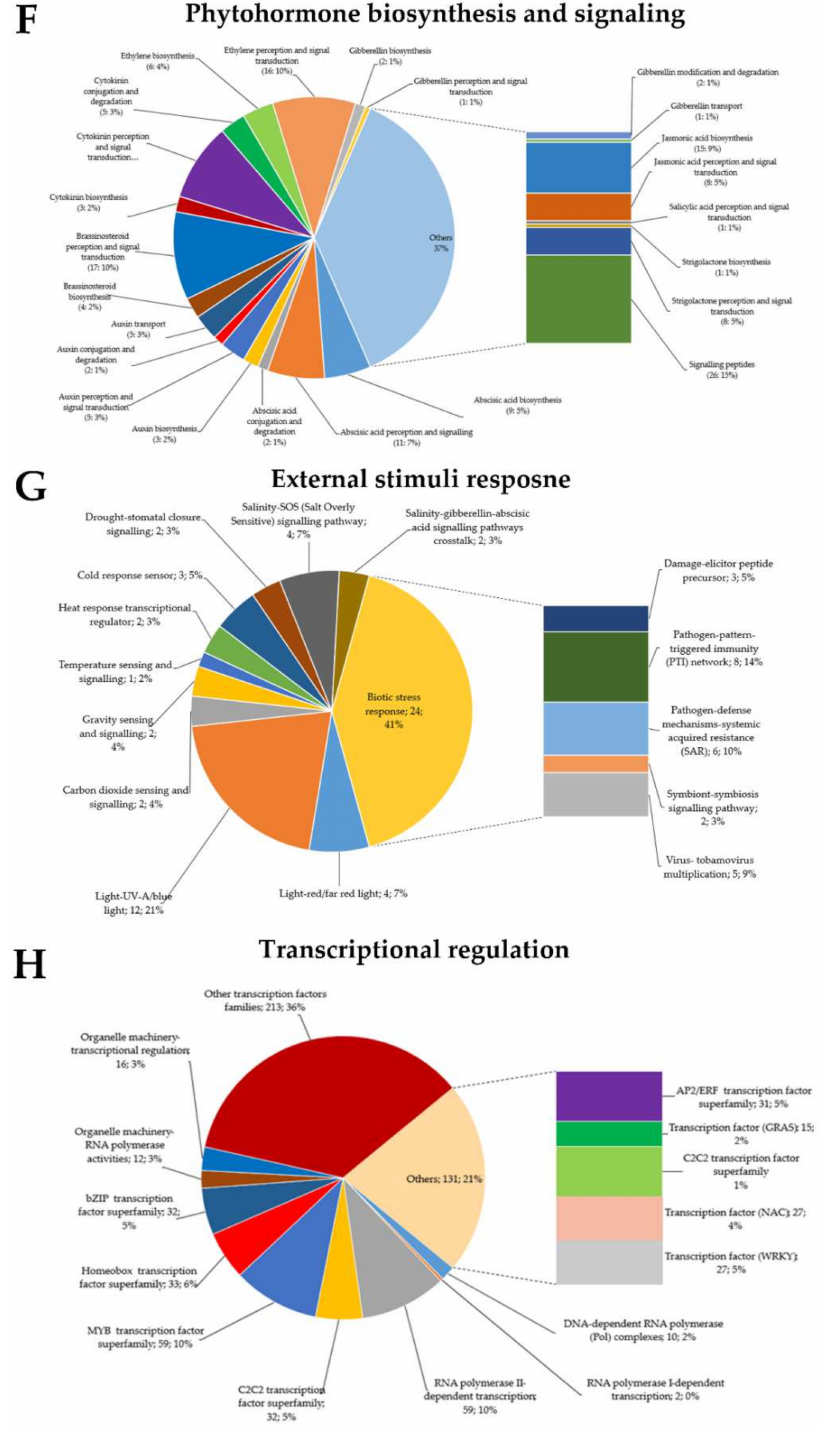
Figure 4. Gene Ontology (GO) terms of green rice leafhoppers fed rice. Differentially expressed genes (DEGs) as- sociated with ( A ) photosynthesis, ( B ) cellular respiration, ( C ) carbohydrate metabolism, ( D ) secondary metabolism, ( E ) reduction–oxidation (redox) homeostasis, ( F ) phytohormone biosynthesis and signaling, ( G ) external stimuli response, and ( H ) transcriptional regulation in response to green rice leafhopper (GRH)-induced biotic stress in